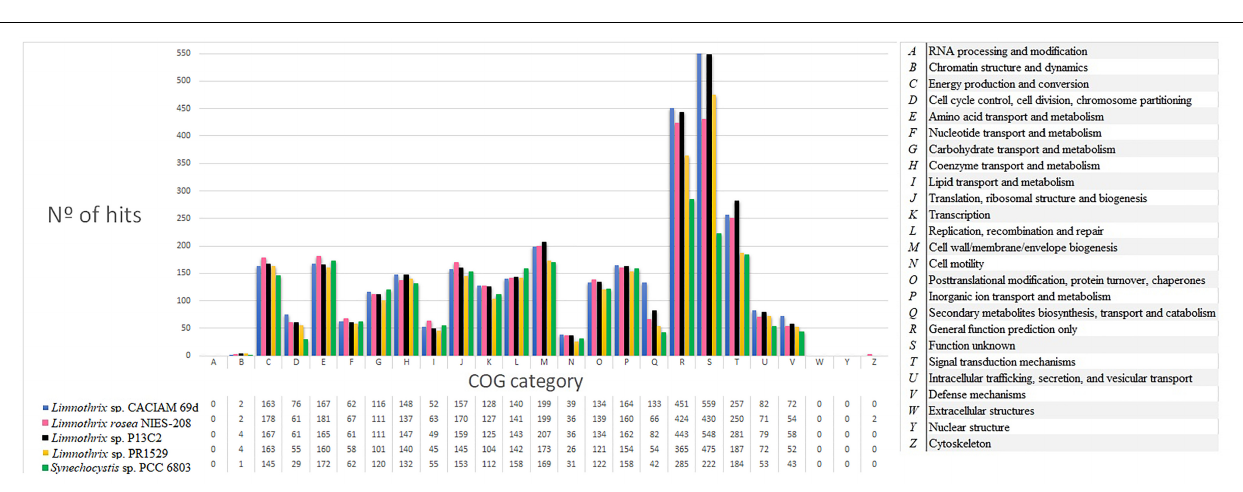
in Limnothrix in comparison to Synechocystis sp. PCC